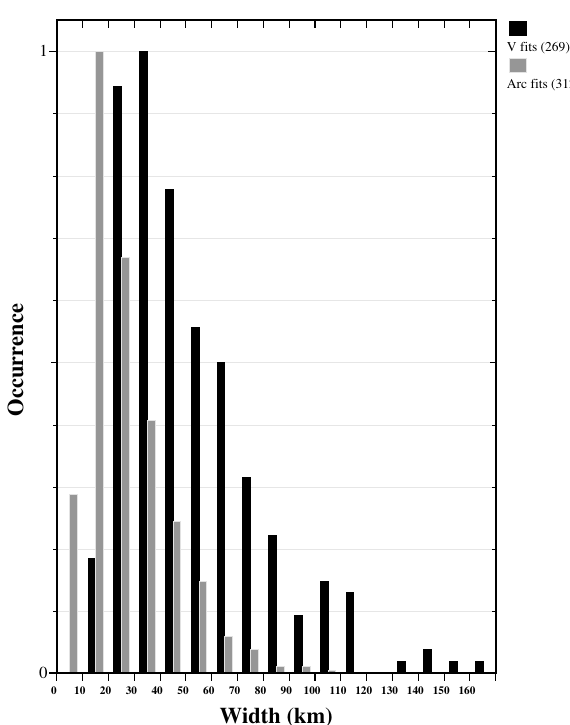
Fig. 12. Distribution of full-width half-maximum (FWHM) values of the inverted-V’s as determined from the Gaussian fitting (black bars) compared to the FWHM values of auroral arcs according to Knudsen et al. (2001). Both distributions are similarly shaped but arc widths peak on smaller values.